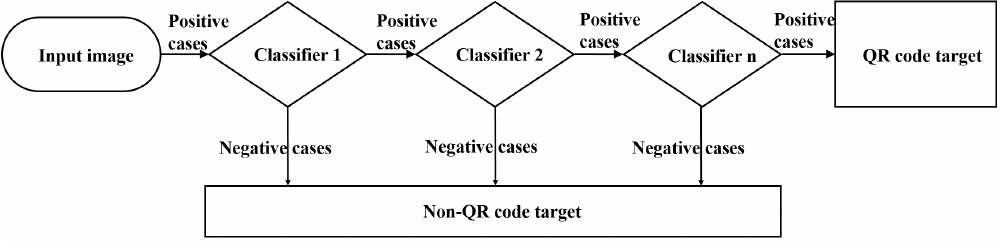
Figure 6. Cascaded classification model for quick response (QR)-code feature